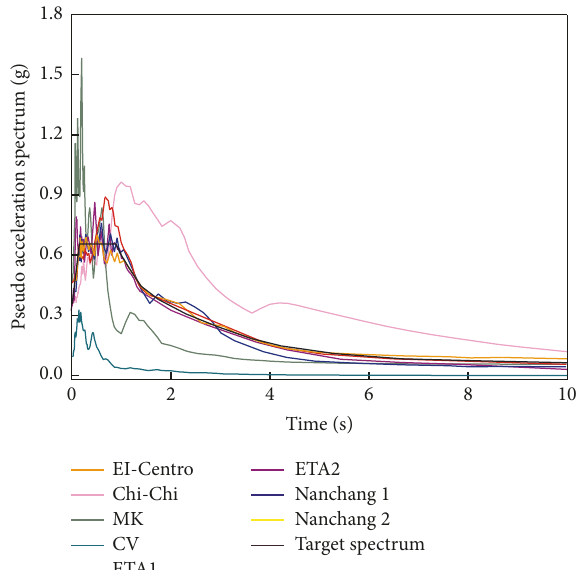
Figure 5: Response spectra of scaled ground motion (damping ratio 5%).